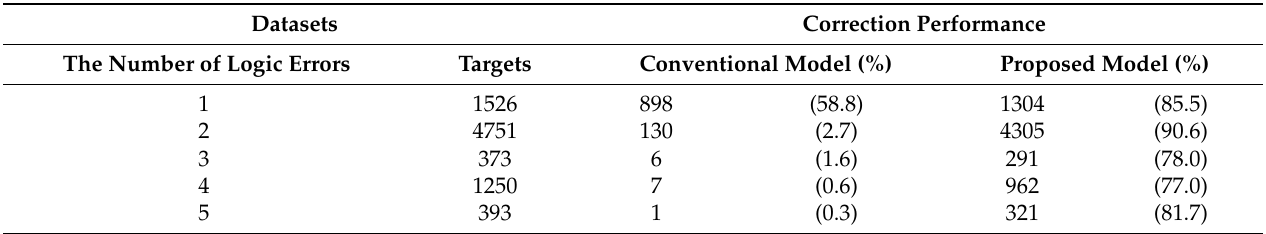
Table 7. Correction performance for each number of logic errors of all problems.